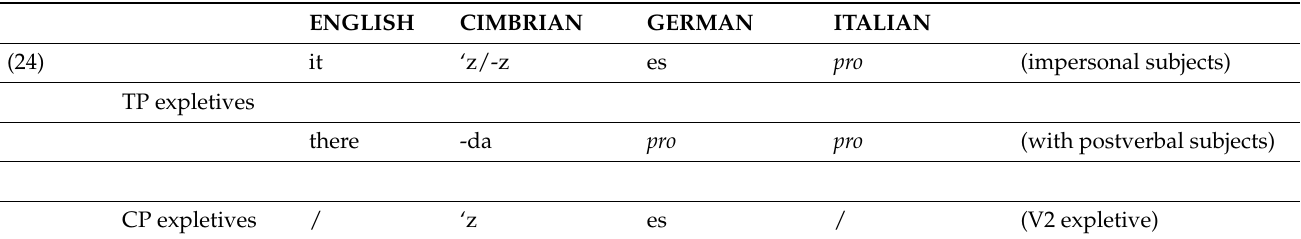
Table 1. Typology of lexical expletives 8